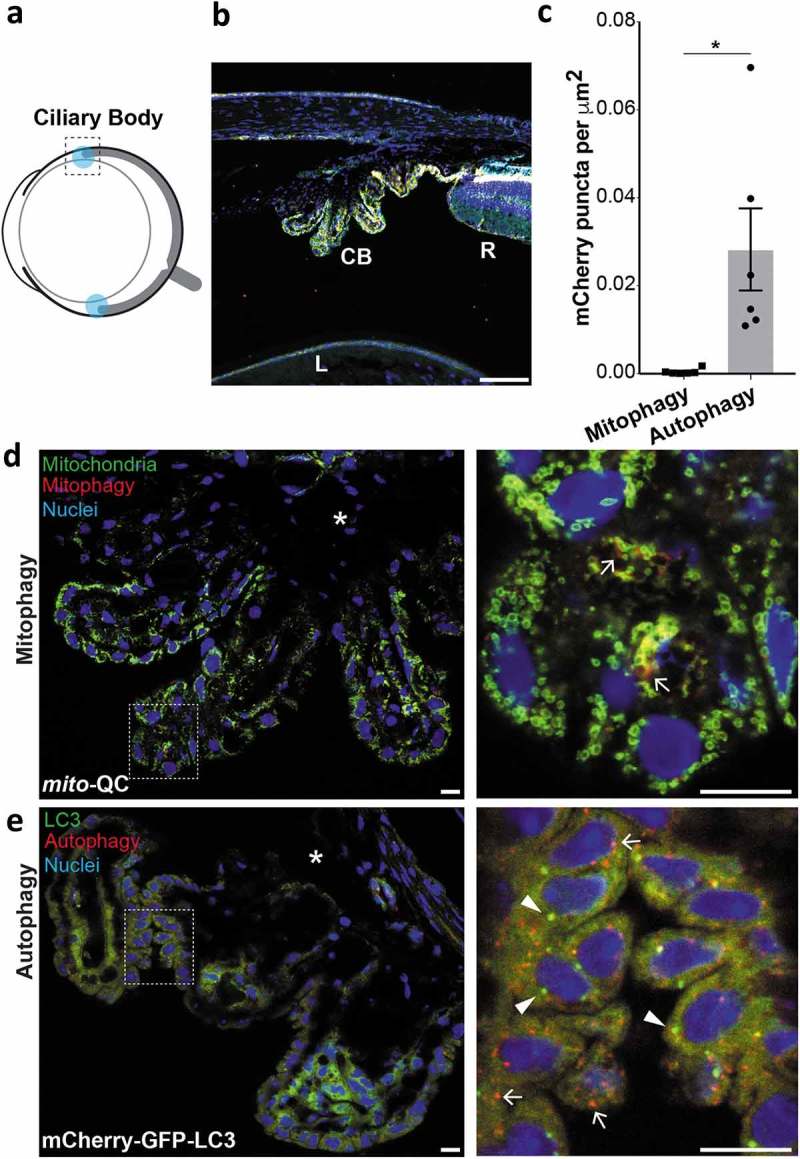
Mitophagy and macroautophagy in the ciliary body. (a) Schematic of the adult mouse eye depicting anatomical location of the ciliary bodies in light blue. (b) Optical section from mito-QC eye showing ciliary body (CB); peripheral retina (R); lens (L). Scale bar: 100 μm. (c) Quantification of mCherry-only puncta from mito-QC (mitophagy) or mCherry-GFP-LC3 (autophagy) ciliary body sections. Data points represent means from individual animals ±SEM (*P < 0.05 (0.031)). (d) Optical section from mito-QC eye detailing ciliary body. Boxed region is shown magnified on the right and arrows mark examples of mitolysosomes. Asterisk marks area of highly pigmented ciliary epithelium, with the pigment reducing the mCherry-GFP fluorescence. (e) Optical section from mCherry-GFP-LC3 eye detailing autophagy in the ciliary body. Boxed region is shown magnified on the right and arrows mark examples of autolysosomes and arrowheads autophagosomes. Asterisk marks area as in panel D. Scale bars: 10 μm.